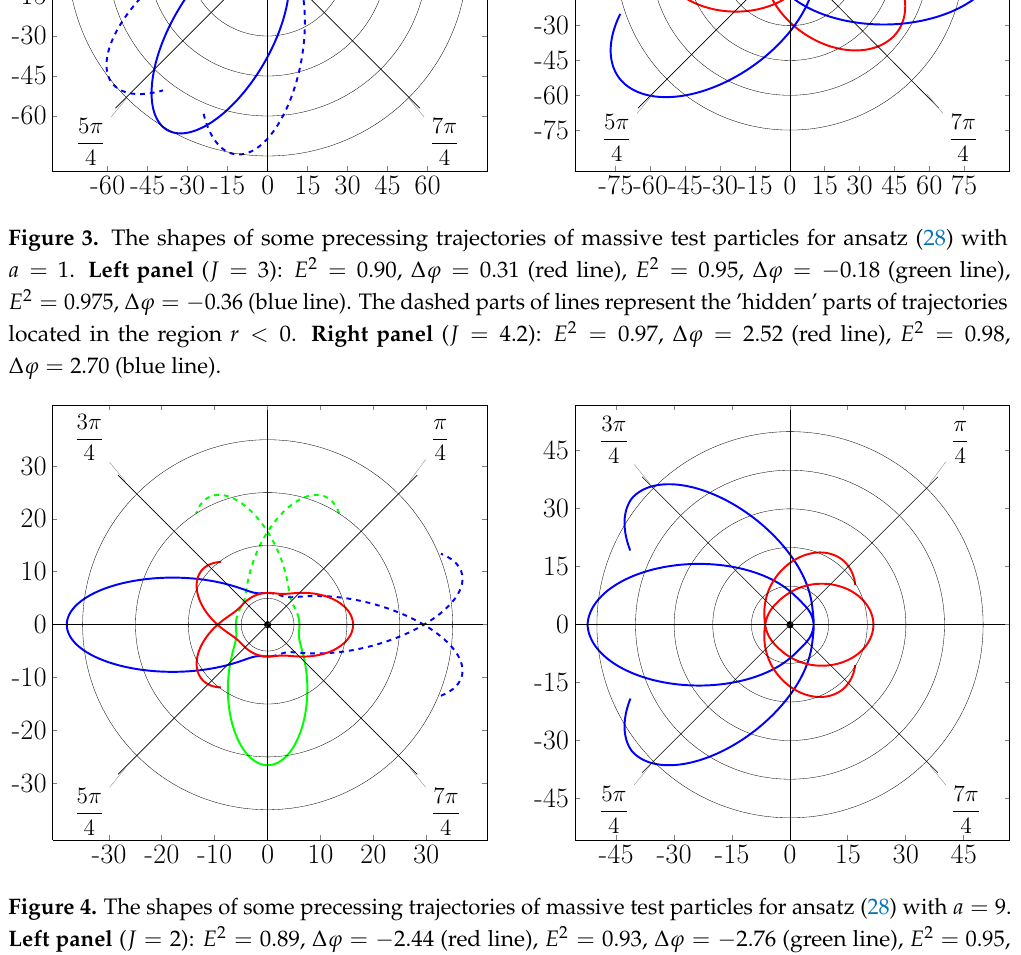
2.44 (red line), E 2 = 0.93, ∆ ϕ = 2.76 (green line), E 2 = 0.95, − − 0.82 (red line), E 2 = 0.965, ∆ ϕ = 0.64 (blue − −